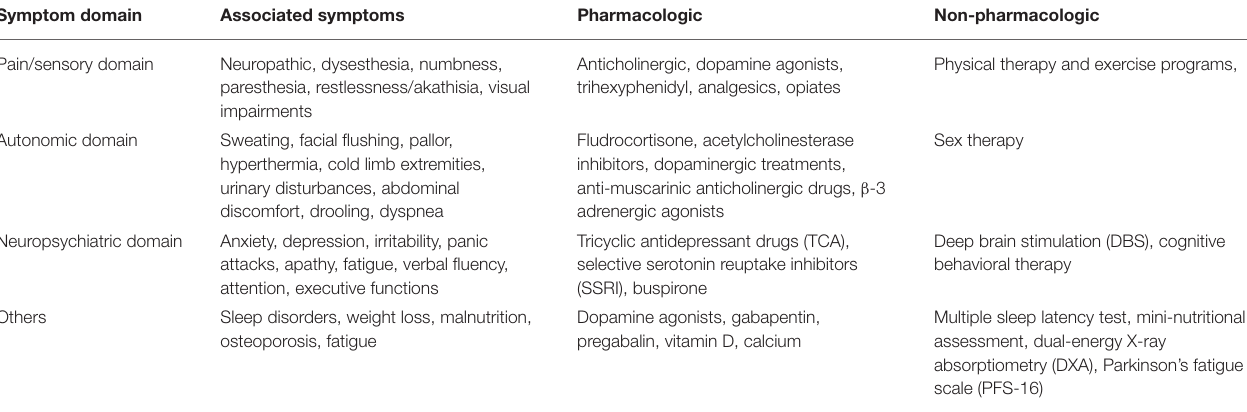
TABLE 1 | Treatments for motor and non-motor